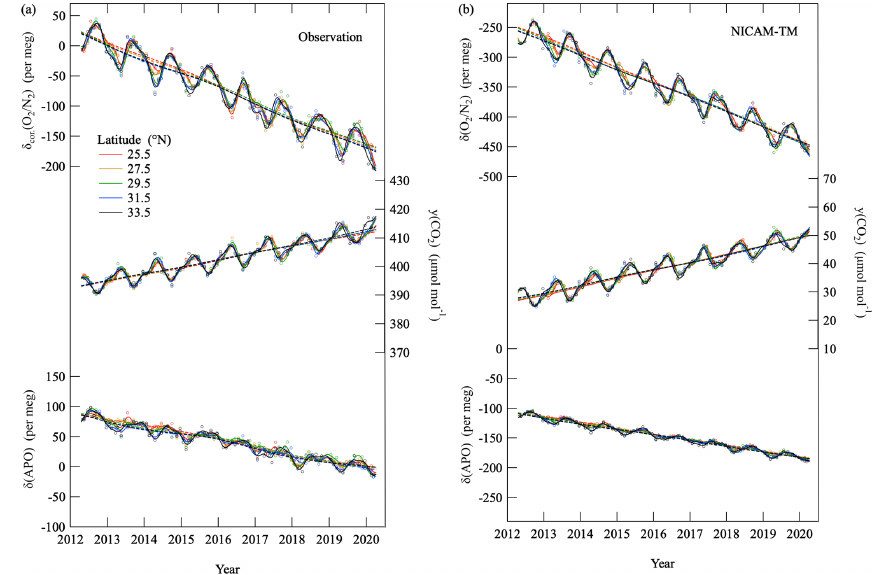
Figure 4. (a) δ cor . (O 2 / N 2 ), CO 2 amount fraction and δ (APO) observed at the altitude of (6 . 1 ± 0 . 5) ( ± 1 σ )km at various latitudes over the western North Pacific. Best-fit curves to the data (solid lines) and secular trends (dashed lines) are also shown (Nakazawa et al., 1997a). (b) Same as in (a) but for calculated values obtained from the NICAM-TM control-run. The data from NICAM-TM are reported on arbitrary scales different from those of observations.